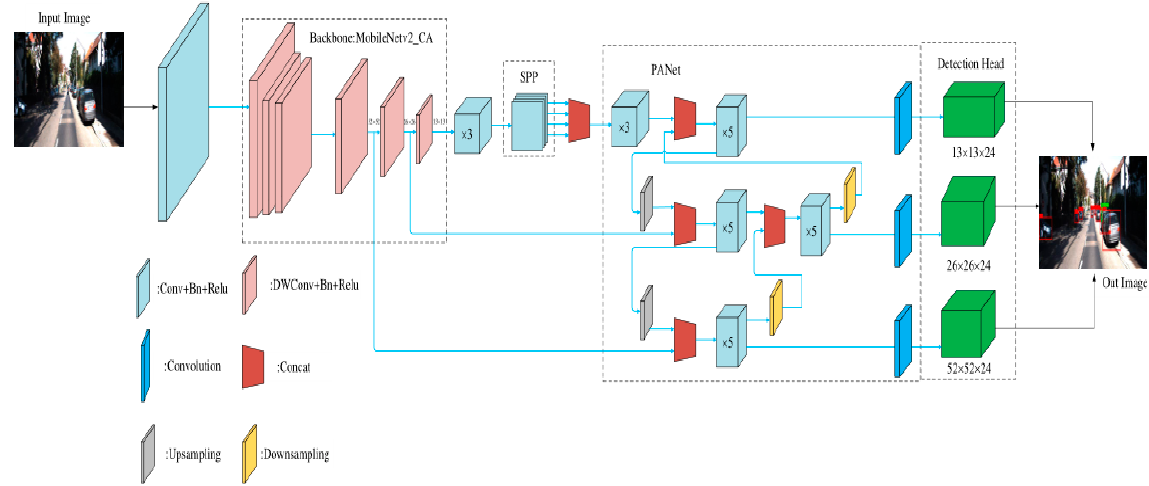
Figure 2. The input image is passed through the backbone feature extraction network to the multi- scale pooling layer, multi-scale fusion is performed, and, finally, the detection result is output.